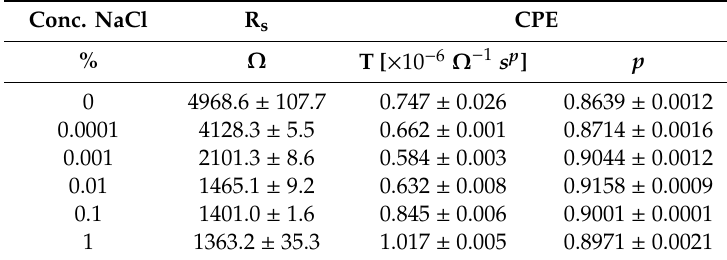
Table 1. Extrapolated values of the designed equivalent circuit parameters from the fitting results in Figure